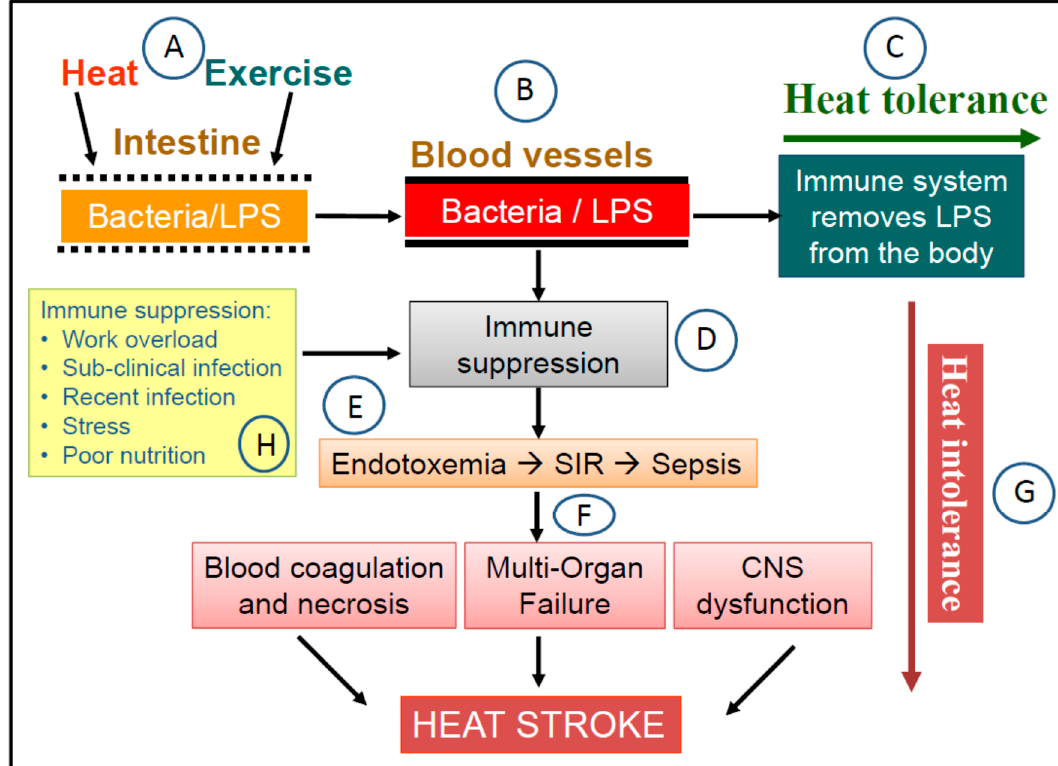
Figure 1. The heat sepsis pathway in the dual pathway model (DPM) of heat stroke (HS). ( A ) Exercise and heat stresses cause the permeability of the gut epithelium to increase, which leads to the leakage of gram-negative bacteria and lipopolysaccharides (LPS) from the gut into the circulatory system ( B ). In a healthy state, when immune functions are not compromised, LPS in the circulation is removed from the body by monocytes, high density lipoproteins, and LPS-specific antibodies. Under these circumstance, the physical task is completed without heat-related health consequences i.e., heat tolerance ( C ). However, when undertaking the same physical task in a state of immune suppression ( D ) can compromise LPS clearance, which leads to the accumulation of LPS in the blood i.e., endotoxemia ( E ). The concentration of LPS in the blood reaches a threshold that triggers the systemic inflammatory response (SIR), which can lead eventually to sepsis. The resulting clinical presentation include massive blood coagulation, necrosis, cellular damage, multi-organ failure, and central nervous system disturbances ( F ), which are seen in HS victims i.e., a state of heat intolerance ( G ). In this pathway, the state of the immune system can function as a switch between heat tolerance and intolerance i.e., transient heat tolerance. Examples of circumstances that can cause immune suppression are also suggested in the diagram ( H ).